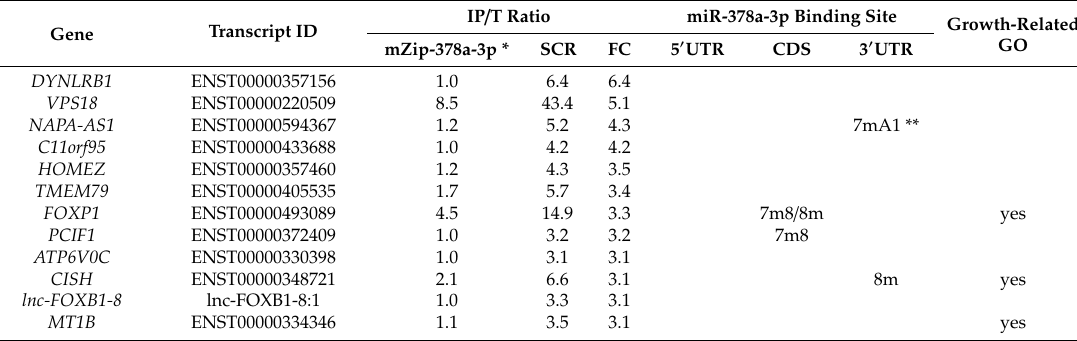
Table 3. Identified targets of miR-378a-3p upon